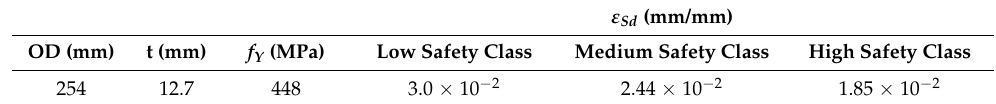
Table 3. Failure criteria for different safety classes.